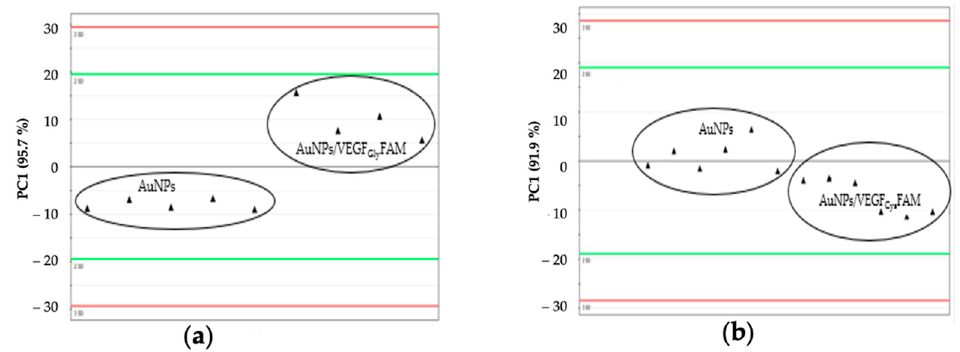
Figure 9. PC1 Score Plot obtained from PCA analysis of positive ToF-SIMS spectra (at least five spectra for each sample) of bare and functionalized AuNPs with VEGF Gly FAM peptide ( a ) and VEGF Cys FAM ( b ).